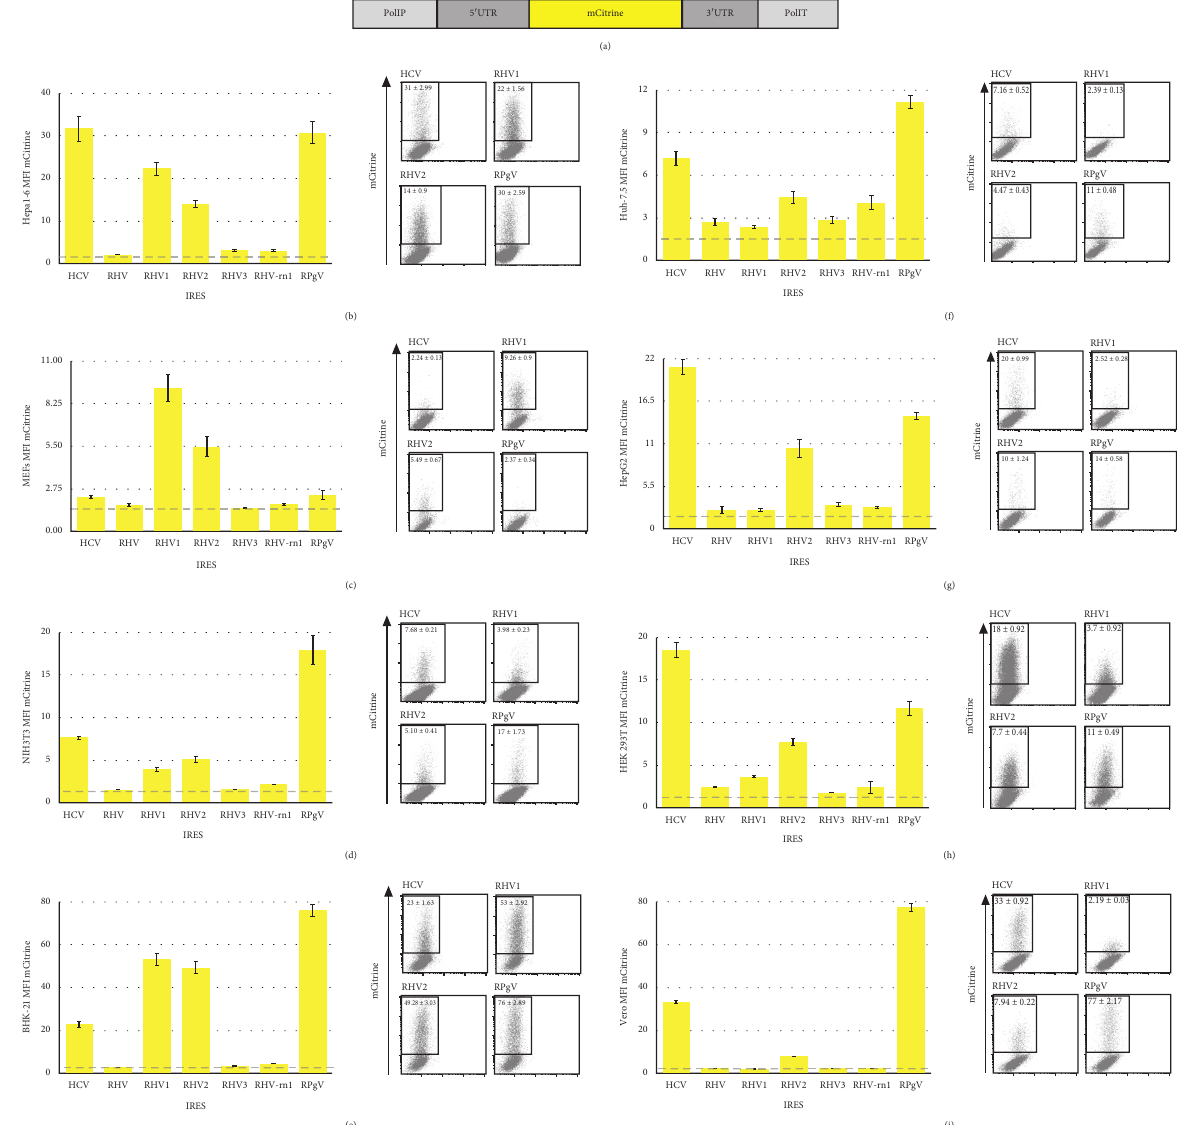
Figure 2: RHV and RPGV IRES activity in different cell types. Schematic of the monocistronic vectors used (a). Hepa1-6 (b), MEFs (c), NIH 3T3 (d), BHK-21 (e), Huh7.5 (f), HEK 293T (h), and Vero (i) cells were transfected with the indicated plasmids. Cells were harvested and analysed by flow cytometry at 48h.p.t.; bar graphs show MFI for mCitrine ( n ≥ 8, mean ± SEM of at least three independent experiments), and representative FACS plots on the right of each graph numbers represent the MFI (mean ± SEM). The dashed line represents the fluorescent output of the control plasmid containing a scrambled sequence in place of the viral 5 ′